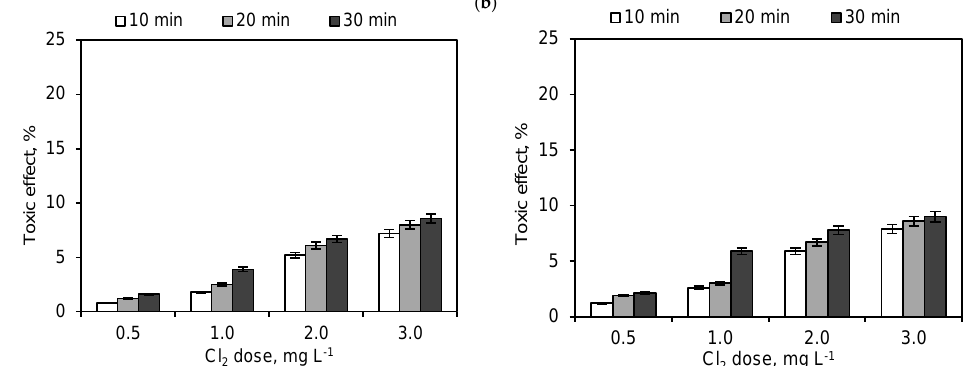
Figure 9. Change in the toxicity of chlorinated ( a ) deionized and ( b ) surface water samples without the addition of CECs.